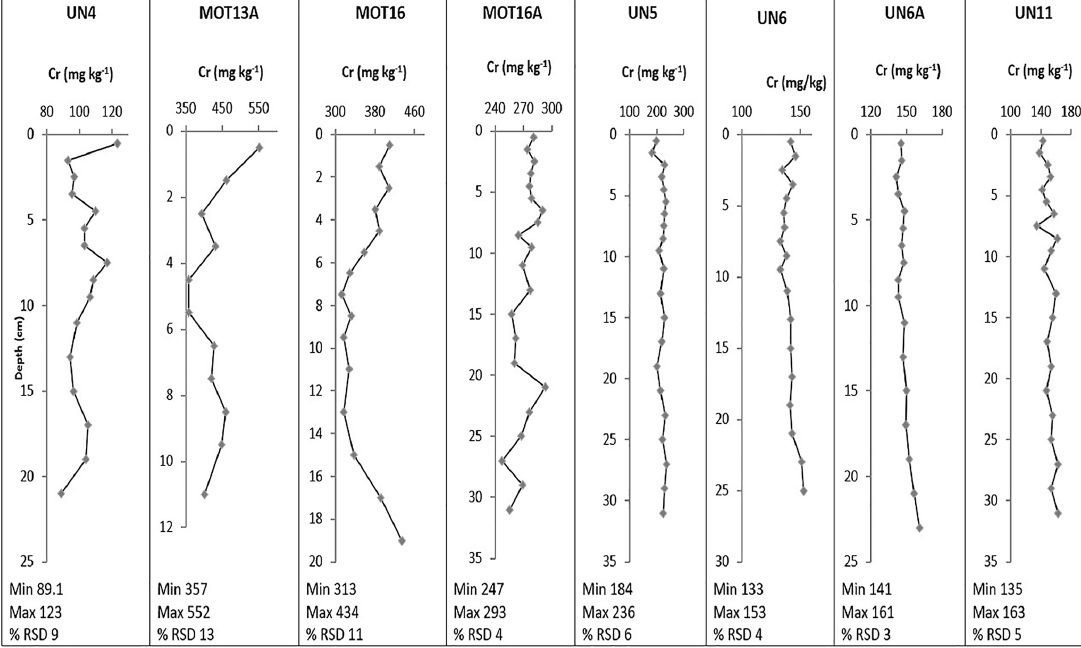
Figure A2. Vertical distributions of Cr (in mgkg − 1 ) in sediment cores. The concentrations in the coarse cores MOT13A, MOT16 and UN4 refer to the total sediment fraction ( <